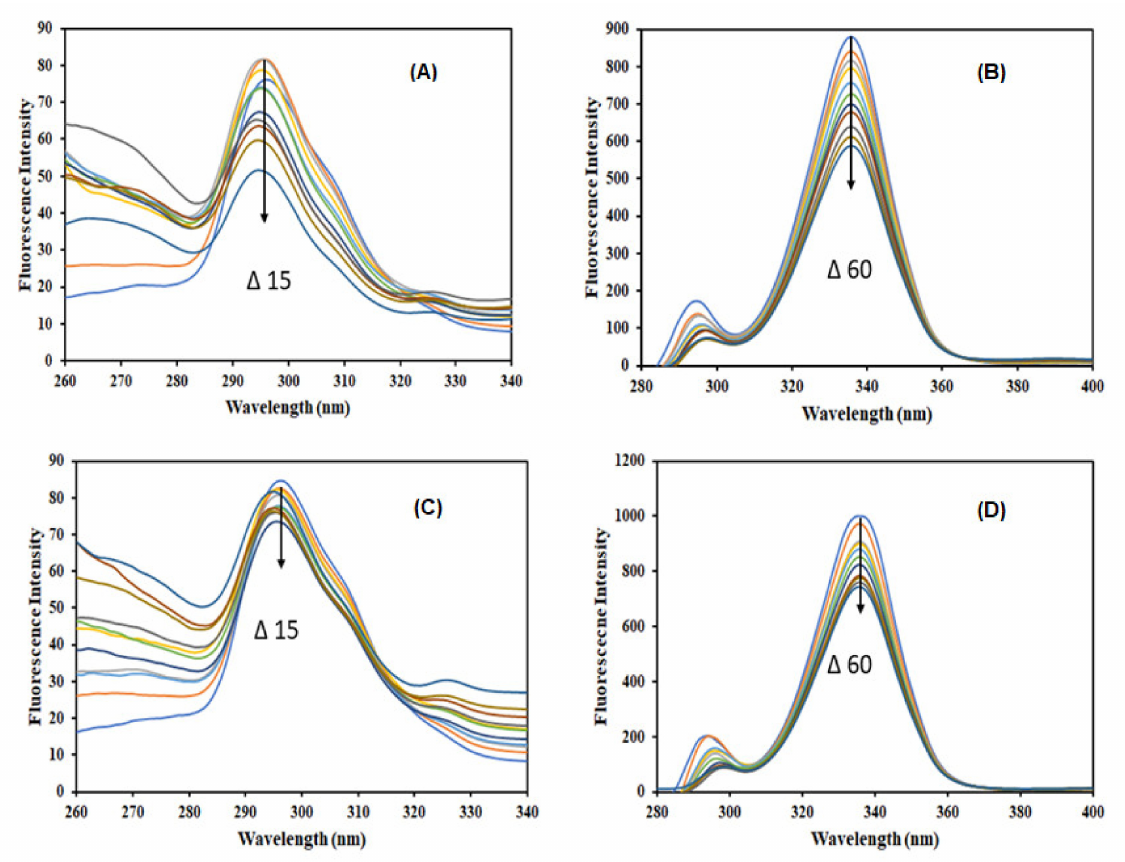
Figure 3. Synchronous fluorescence spectra for ( A ) Tyrosine residue ( ∆ λ = 15) and ( B ) Tryptophan ( ∆ λ = 60) of α -amylase (4 µ M) in the absence and presence of caffeic acid (0–40 µ M). Panel ( C , D ) are the spectra obtained under similar conditions for p-coumaric